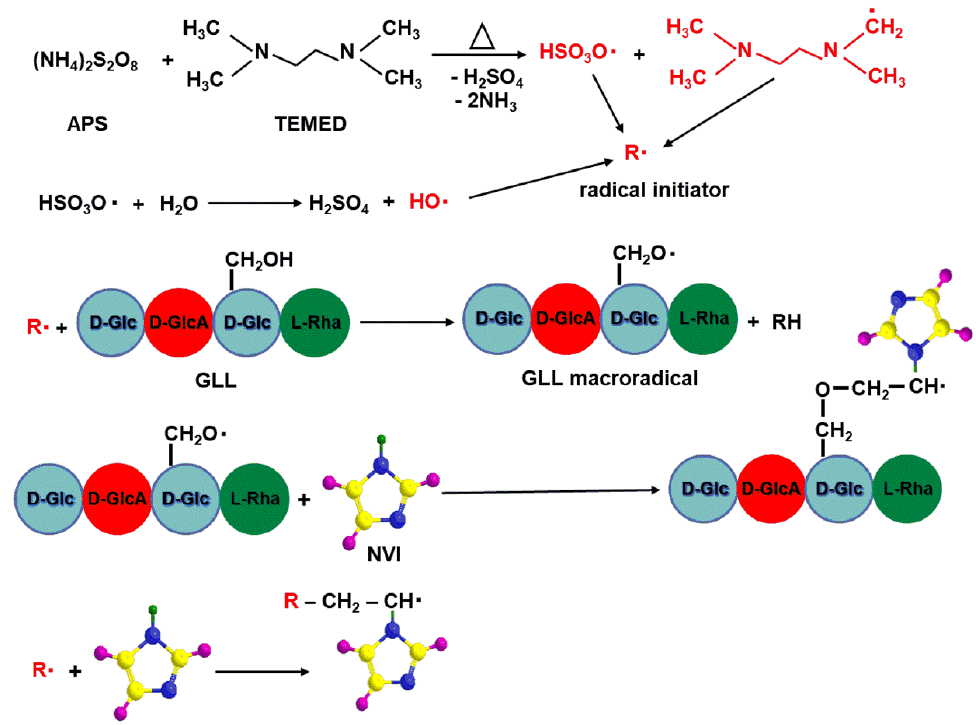
Figure 5. Initiation step of grafting copolymerization.